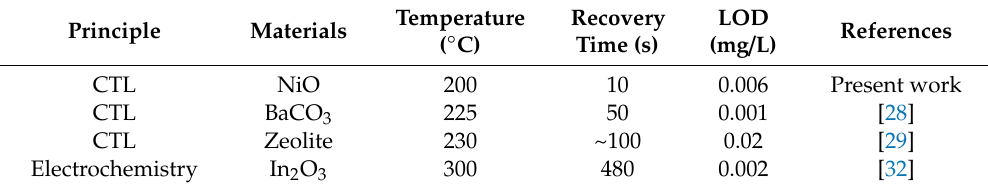
Table 1. Comparison of performances of acetaldehyde gas